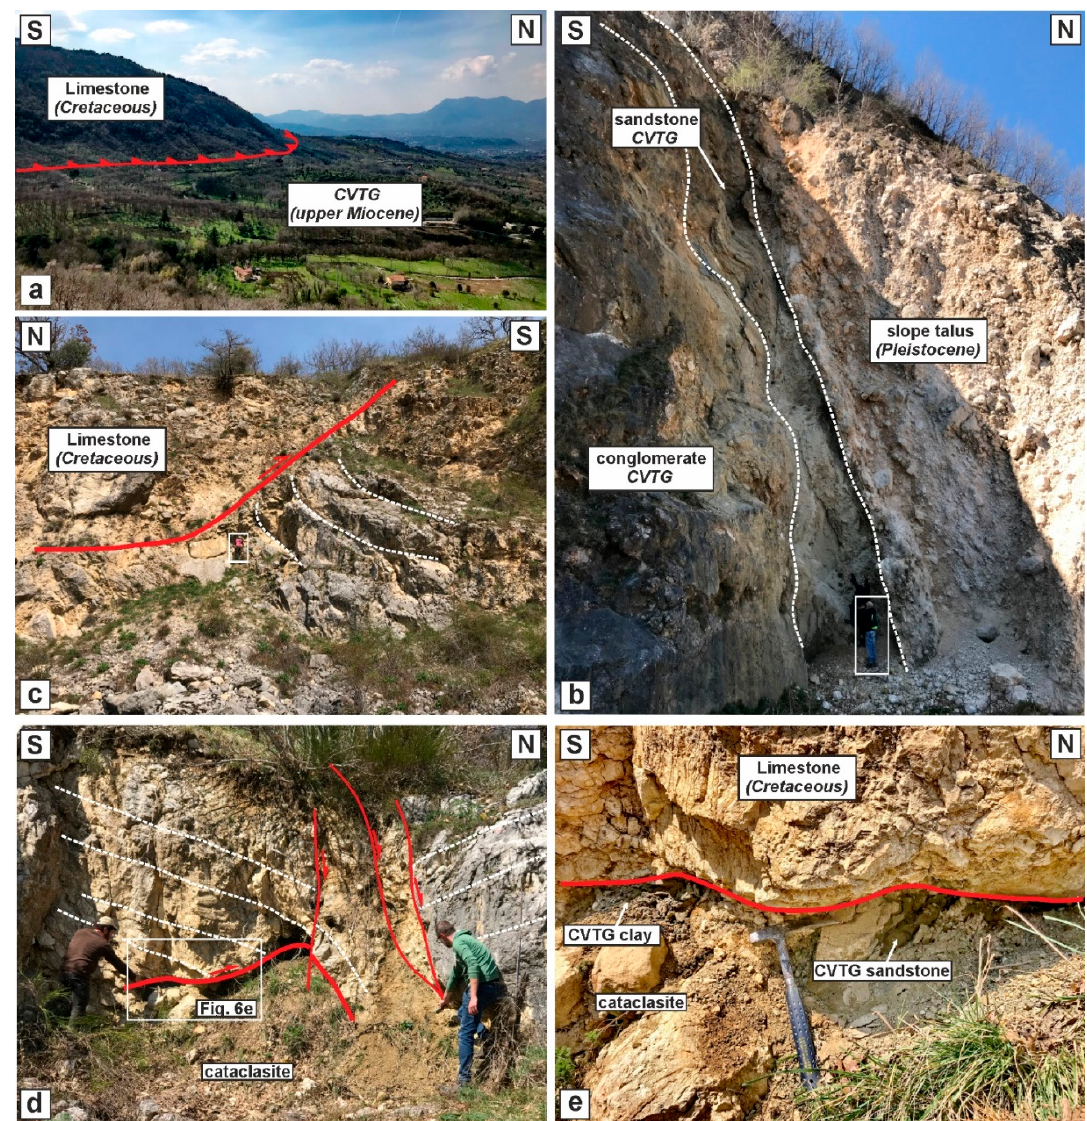
Figure 6. Chiusano area: ( a ) panoramic view of the frontal thrust; ( b ) highly dipping forelimb of the hanging wall anticline associated to the frontal thrust formed by Upper Cretaceous carbonates covered by beds of Castelvetere Group (CVTG) conglomerates and sandstones; the succession is covered by the Middle Pleistocene slope talus (Belvedere quarry); ( c ) back-thrust within the Upper Cretaceous limestones with an associated footwall syncline. Castelvetere area: ( d ) the main thrust crosscut by late normal faults; ( e ) particulars of the cataclasite in the footwall made of lenses of clays and sandstones of the CVTG.